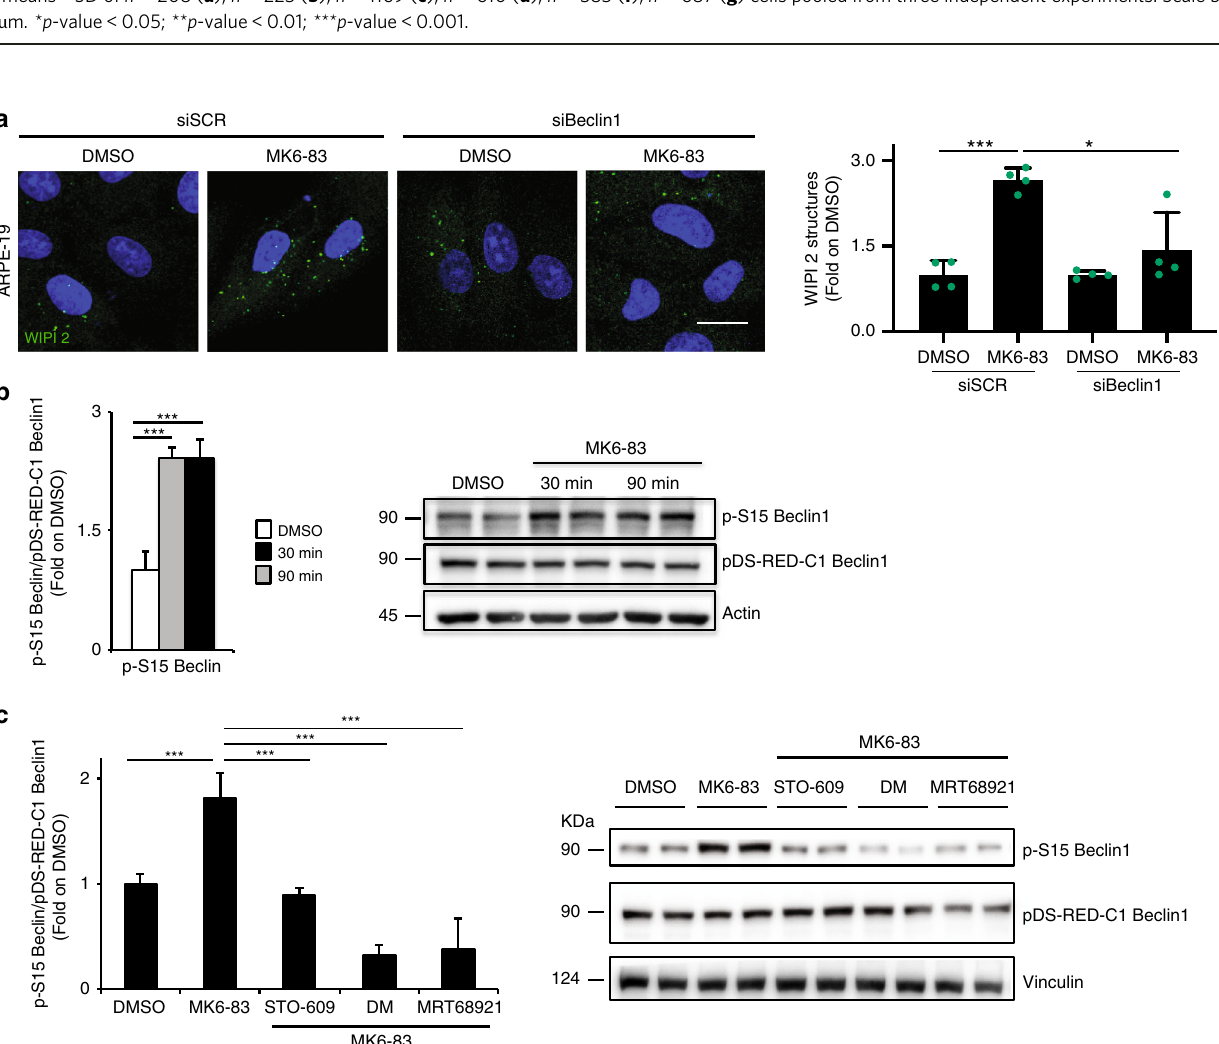
Fig. 4 TRPML1-mediated lysosomal Ca2 + release induces AV biogenesis through CaMKK β . a Representative images of HEK-293 overexpressing DFCP1-GFP treated with DMSO and MK6-83 ± BAPTA-AM. b Representative images of WIPI2 in ARPE-19 treated with DMSO and MK6-83 ± BAPTA-AM. c Representative images of WIPI2 in ARPE-19 treated with DMSO and MK6-83 alone or in co-treatment with STO-609. d Representative images of WIPI2 in ARPE-19 treated with a pool of three siRNAs targeting CaMKK β or CaMKI ± MK6-83. e Representative image of immunoblot analysis of LC3 (LC3I-II) in HeLa cells silenced with siRNAs targeting CaMKI and treated with MK6-83 ± ba fi lomycin A1 (BafA1). Plot shows the densitometry of LC3II normalized to actin as fold induction to DMSO. The data in the graphs on the right are mean values ± SD, n = 4 lysates per condition pooled from four independent experiments. f Representative images of WIPI2 in ARPE-19 treated with DMSO and MK6-83 ± dorsomorphin. g Representative images of HEK-293 overexpressing DFCP1-GFP treated with DMSO and MK6-83± dorsomorphin (DM). h Representative image of immunoblot analysis of phosphorylation AMPK on T172 and ULK1 on S555, Acetyl-CoA Carboxylase (ACC) on S79, upon MK6-83 treatment. Plot shows the densitometry of p-AMPK T172, p-ULK1 S555, and p-ACC S79 on AMPK, ULK1, and ACC normalized on Actin as fold induction to DMSO. The data in the graphs are mean values± SD, n = 3 lysates per condition pooled from three independent experiments. i Representative image of immunoblot analysis of phosphorylation of AMPK on T172 and its substrate ULK1 on S555 upon MK6-83 treatment ± STO-609 or dorsomorphin. Plot shows the densitometry of p-AMPK T172 and p-ULK1 S555 on AMPK and ULK1 normalized on actin as fold induction to DMSO. The data in the graphs are mean values ± SD, n = 4 lysates pooled from four independent experiments. a – d , f , g Plot shows the quanti fi cation of -WIPI2 ( b – d , f ), -DFCP ( a , g ) positive puncta as fold induction to DMSO-treated cells. Values are means ± SD of n = 208 ( a ), n = 225 ( b ), n = 1169 ( c ), n = 610 ( d ), n = 385 ( f ), n = 687 ( g ) cells pooled from three independent experiments. Scale bar: